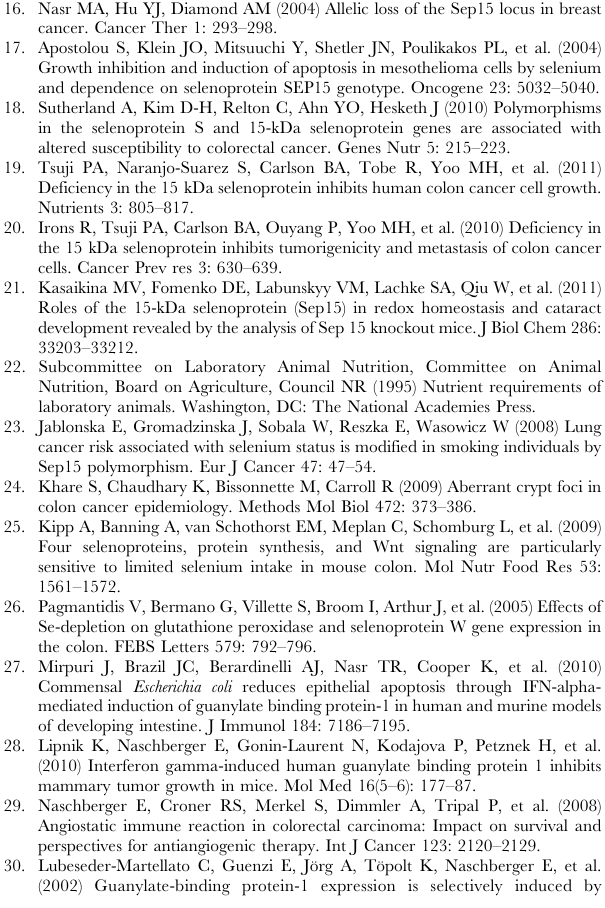
Table S1 Primers used for measuring the mRNA levels for selenoproteins and genes in the Sep15 knockout mouse model by real-time PCR.